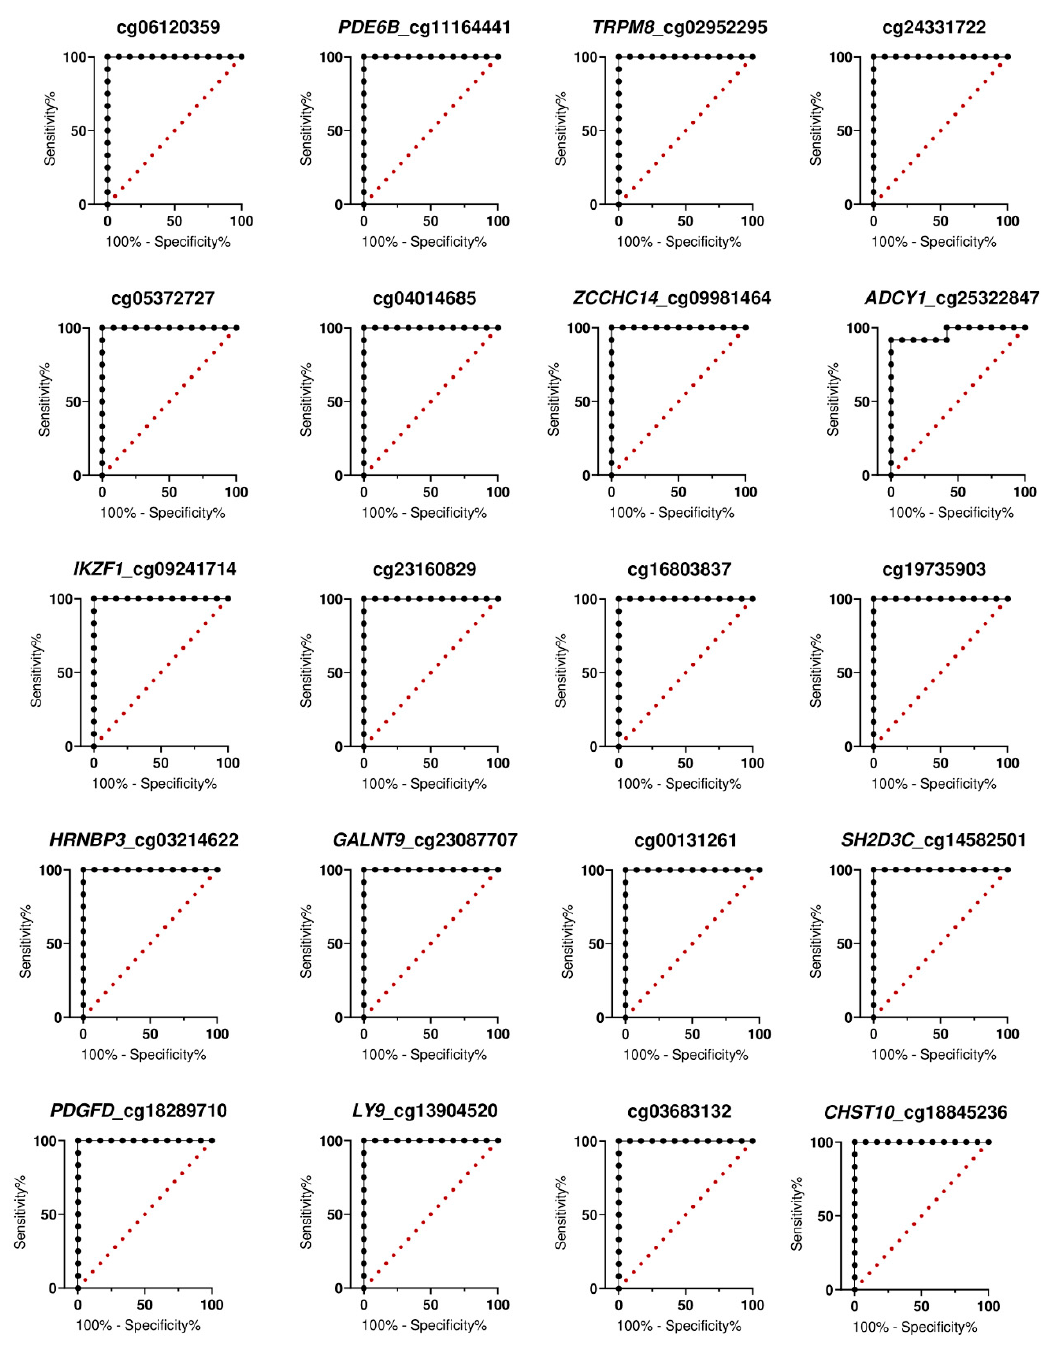
Figure 5. ROC curve-based evaluation of the diagnostic accuracy of hypomethylated open chromatin methylation markers. methylation